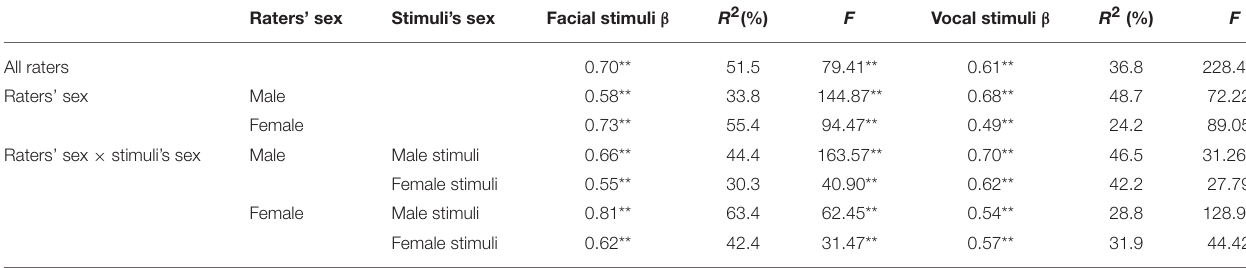
TABLE 3 | Estimated regression analyses of all raters, raters’ sex and raters’ sex × stimuli’s sex (contribution rate R 2 ). Raters’